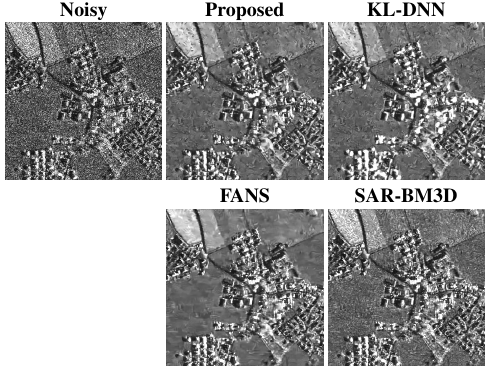
Figure 4. Results on Real Data: Rosenheim area taken from